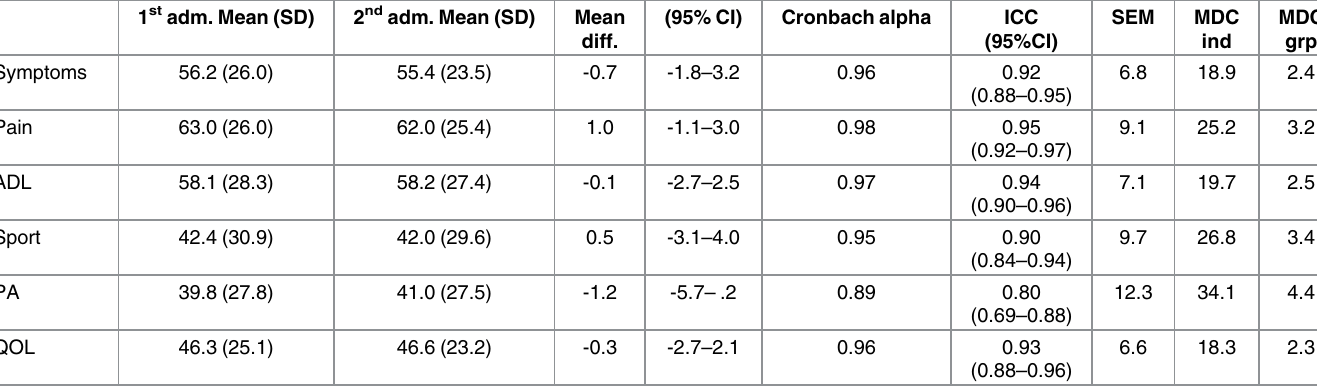
Abbreviations: ICC, Intraclass Correlation Coefficient; 95% CI, 95% Confidence Interval; SEM, standard error of measurement; MDCgrp, smallest detectable change at the group level; MDCind, smallest detectable change at the individuallevel; Symptoms, symptoms in hip and/or groin; Pain, pain in hip and/or groin; ADL, function in daily living; Sport, function in sport and recreation; PA, participation in physical activities; QOL, hip and/or groin-related quality of life.